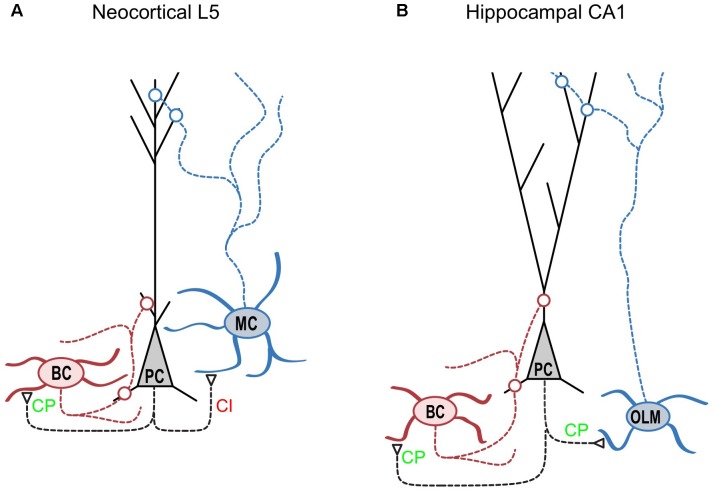
CP-AMPARs are synapse-type-specifically expressed in cortical layer 5. (A) As indicated by CP in green, CP-AMPARs are expressed at synapses from neocortical layer-5 pyramidal cells (“PC,” black) onto basket cells (“BC,” red) but not onto Martinotti cells (“MC,” blue) as indicated by CI in red (see Lalanne et al., 2016). Because CP-AMPARs have faster kinetics, this differential expression helps ensure that BC-mediated somatic inhibition of PCs is fast. However, fast CP-AMPARs would counteract the delayed-onset, dendritic MC-mediated feedback inhibition of PCs (Silberberg and Markram, 2007; Buchanan et al., 2012), which may help explain this differential CP-AMPAR expression. Interestingly, this expression pattern is the precise opposite to that of presynaptic NMDA receptors (Buchanan et al., 2012). (B) In the hippocampal CA1 circuit, CP-AMPARs are found at excitatory connections onto both BCs and O-LM cells. Interestingly, Szabo et al. (2012) also identified CP-AMPARs at PC connections onto nitric oxide synthase-expressing hippocampal INs but not onto cholecystokinin-expressing INs. Excitatory synapses are indicated by open triangles, while open circles denote inhibitory synapses. Modified from (Blackman et al., 2013) with appropriate permission.